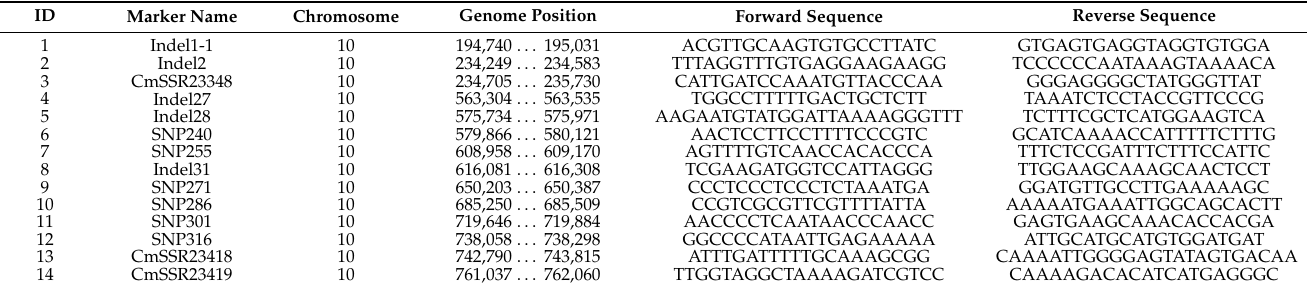
Table 1. Primer information used for fine